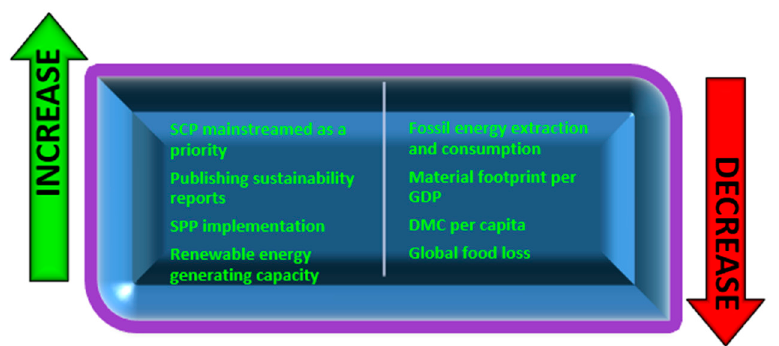
Figure 2. Sustainable infrastructure goals: strengthening responsible consumption and production.